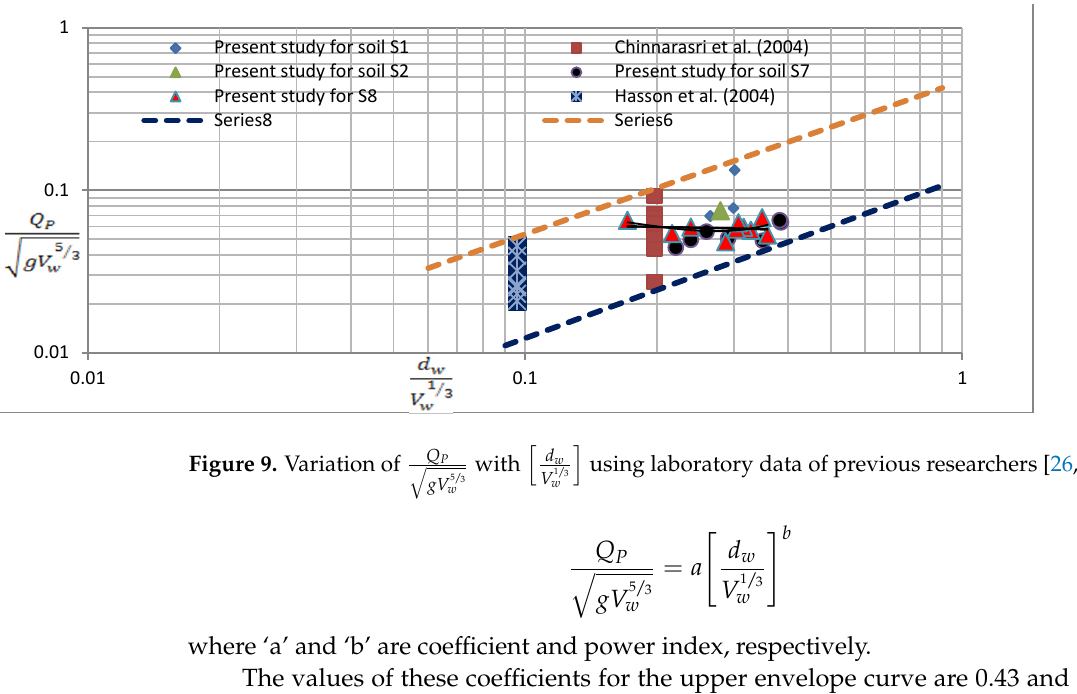
Figure 9. Variation of